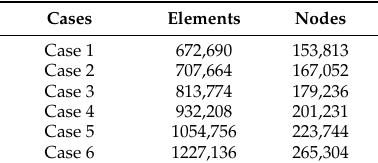
Table 2. Number of nodes and elements used in the simulation for grid dependence test for Model 1.